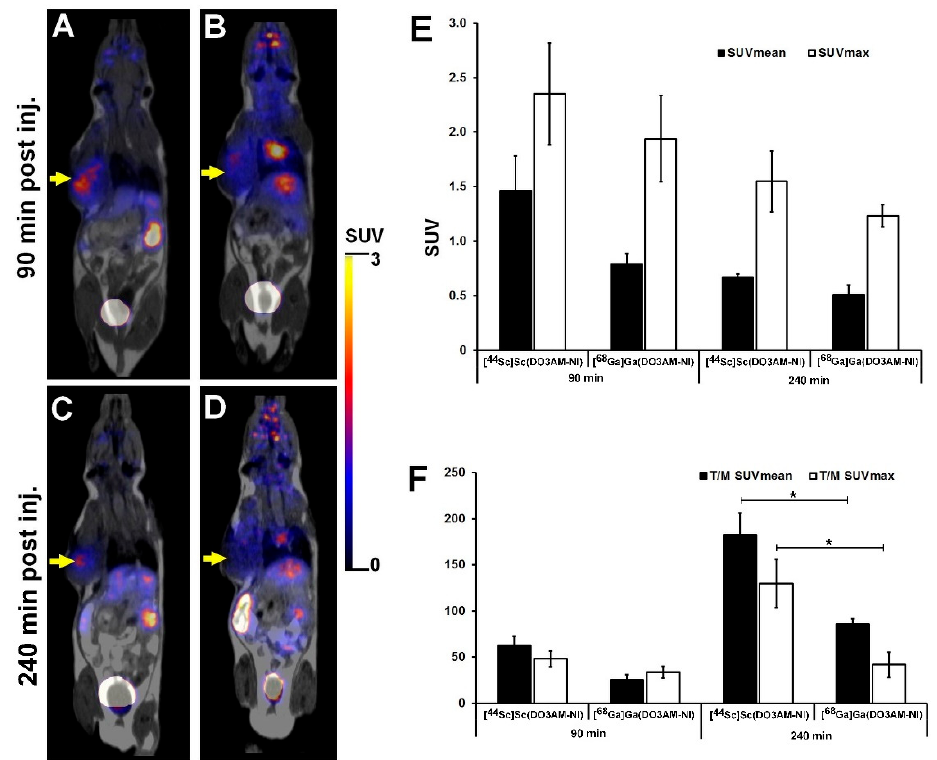
Figure 4. Representative in vivo whole-body PET/MRI imaging of KB tumor-bearing mice using [ 44 Sc]Sc(DO3AM-NI) ( A , C ) and [ 68 Ga]Ga(DO3AM-NI) ( B , D ) 90 and 240 min after intravenous tracer injection. Quantitative SUV analysis of [ 44 Sc]Sc(DO3AM-NI) and [ 68 Ga]Ga(DO3AM-NI) accumulation in experimental tumors ( E , F ). Decay-corrected PET/MRI images and data were obtained 13 ± 1 days after tumor cell inoculation. Yellow arrows: KB tumors. T/M: tumor-to-muscle ratio. Significance level: p ≤ 0.01 (*).